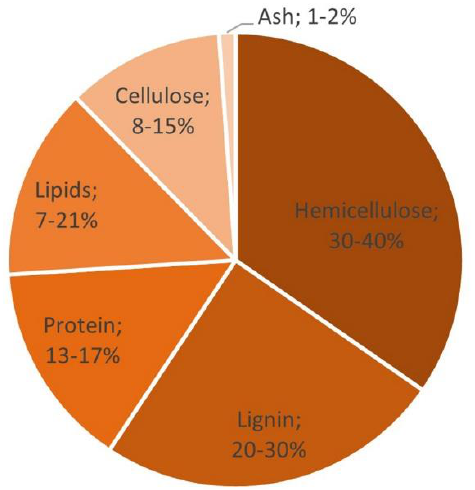
Figure 1. SCG chemical compounds after brewing.